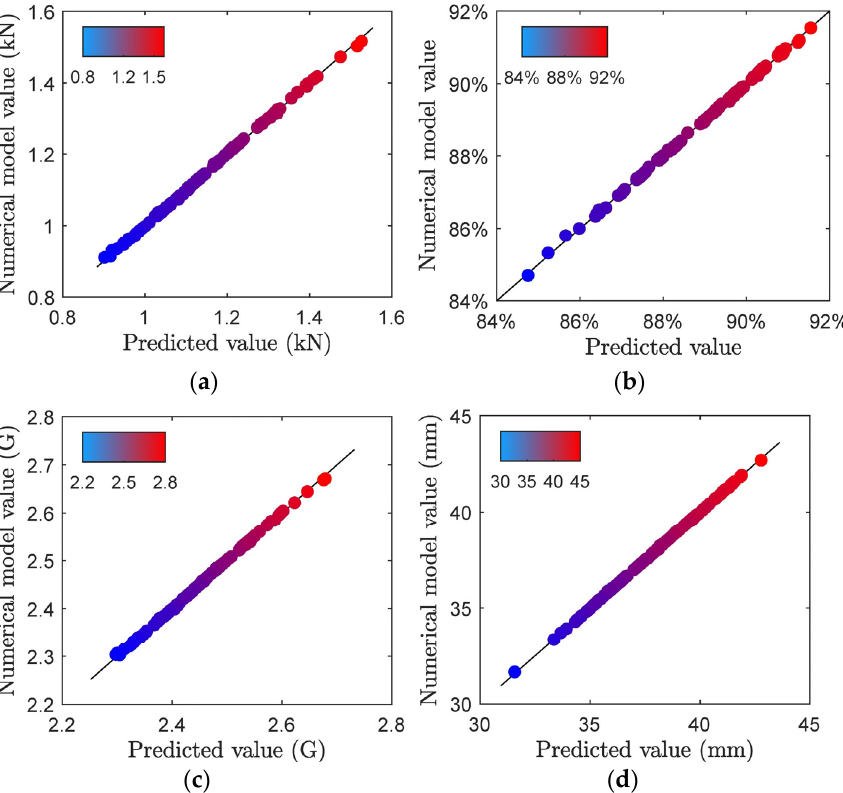
Figure 9. The numerical model values versus the predicted values of the responses: ( a ) Max load of strut friction; ( b ) Shock-strut efficiency; ( c ) Max overloading of the sprung mass; ( d ) Shock absorber stroke.